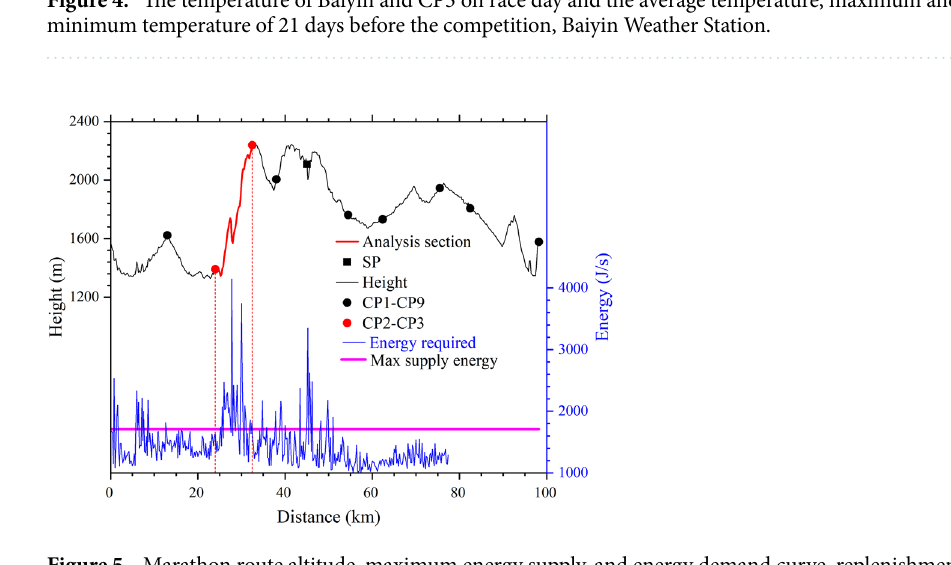
Figure 5. Marathon route altitude, maximum energy supply, and energy demand curve, replenishment points, and check-in points. Calculate the energy required according to the actual temperature at CP3. Since there is no temperature data later, the following data is